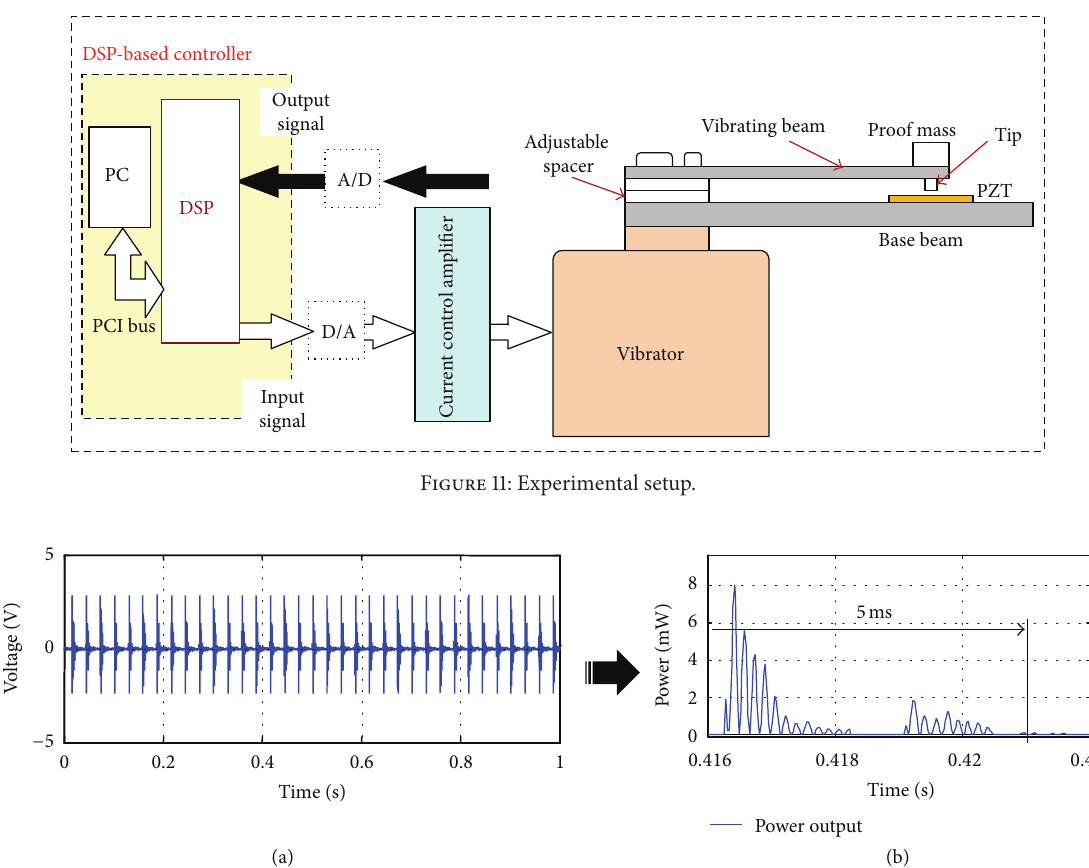
Figure 12: The output signals for a 35 Hz vibration, a spacer thickness of 4 mm and load resistor of 10k Ω . (a) The output voltage; (b) the output